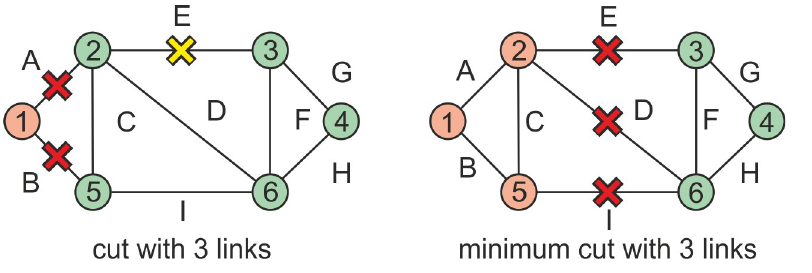
Fig 1. An example of a cut and minimum cut for 3 interrupted